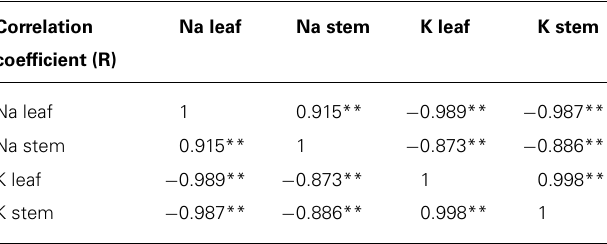
Table 1 | Correlations of Na and K contents in the leaf or inflorescence stem from salt-stressed plants.